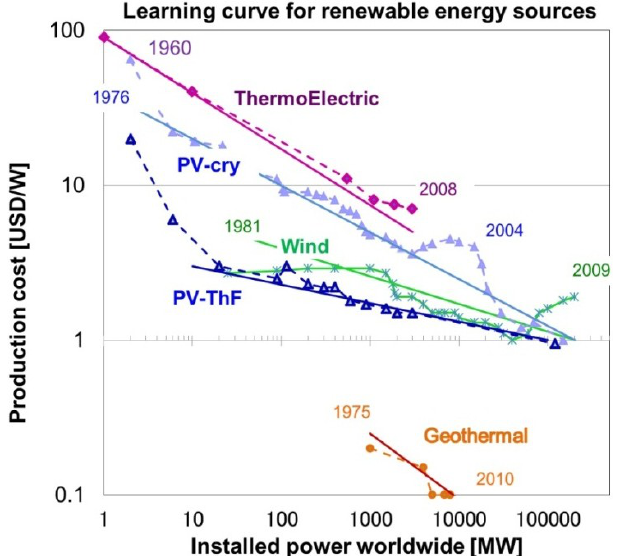
Figure 2. The learning curve compares the production costs for energy from renewable sources as a function of the installed power. PV-cry, photovoltaic crystalline; PV-ThF, photovoltaic thin